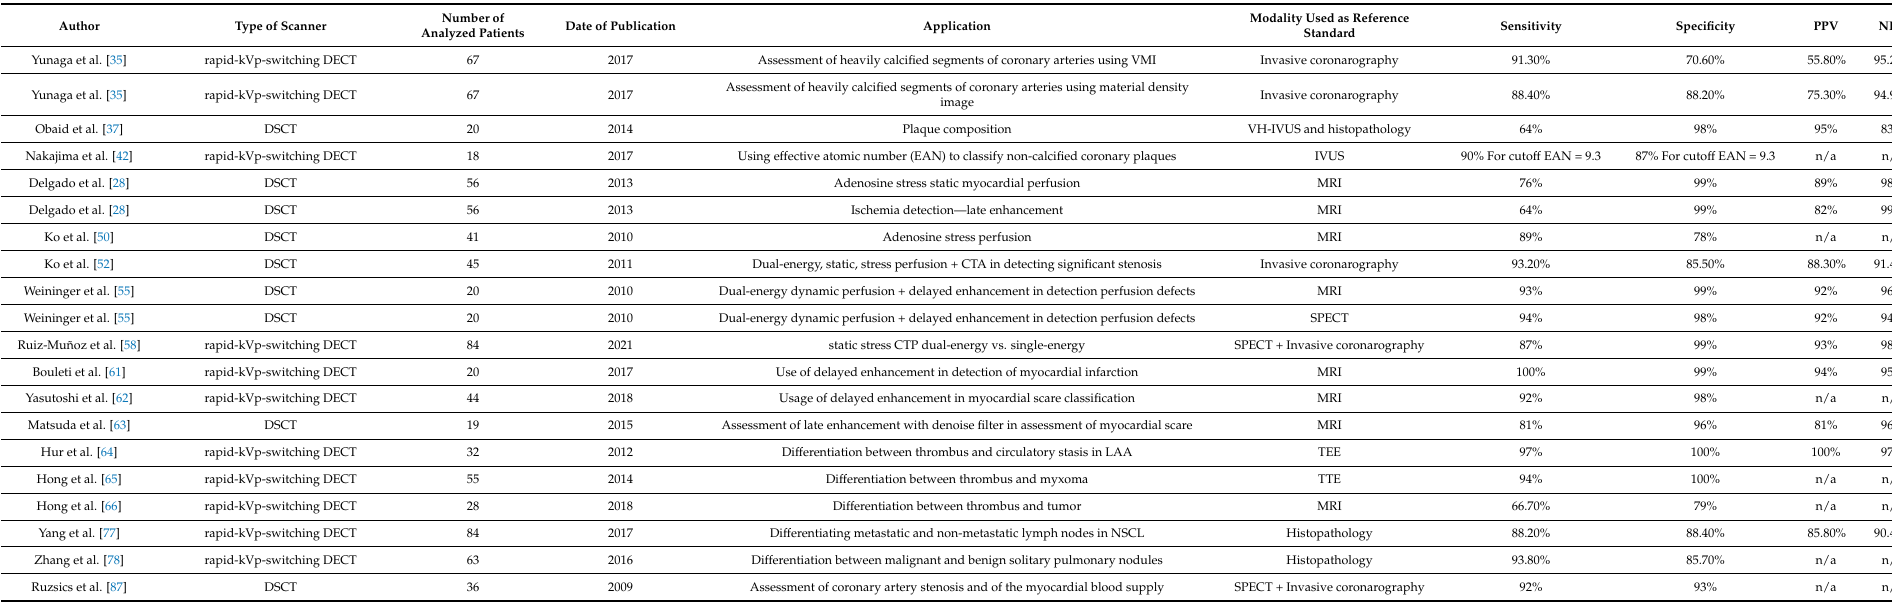
Table 4. Summary of sensitivity, specificity, positive predicting value (PPV), negative predictive value (NPV) and significant details of citated original study comparing DECT with other modalities. n/a—not